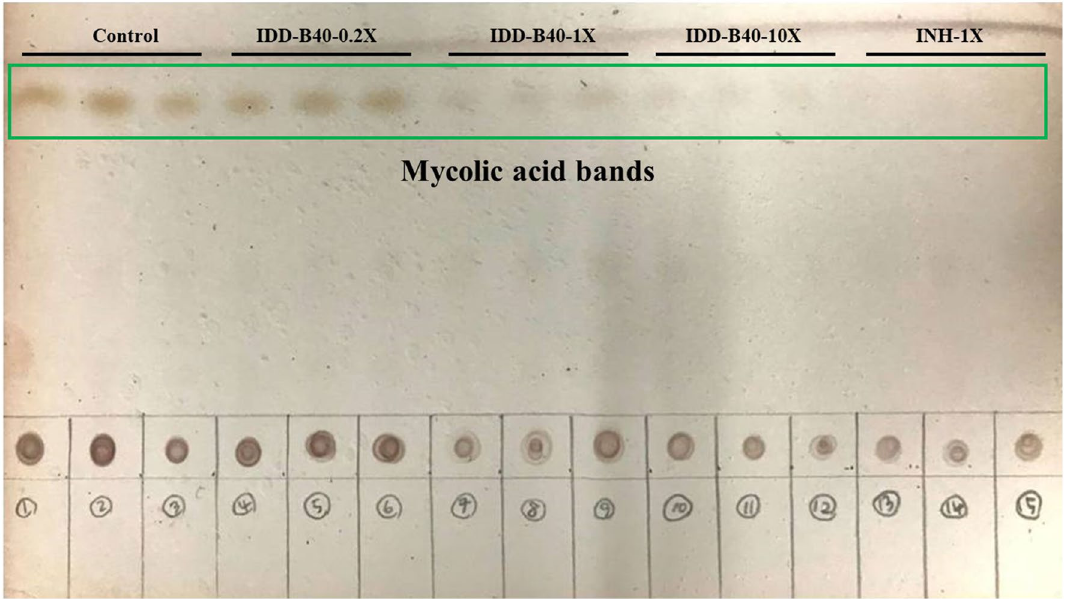
Figure 7. TLC Picture of mycolic acid extracted from H37Rv M. tuberculosis cells after the 7 days treatment of different concentration of IDD-B40 and